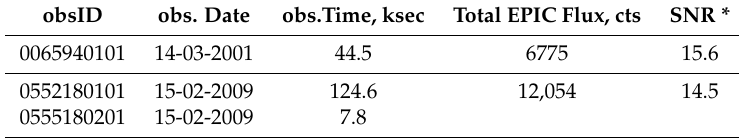
Table A1. XMM-Newton/EPIC observations LOG. The data events from various data shown in one cell were merged together to produce one common spectrum from them.